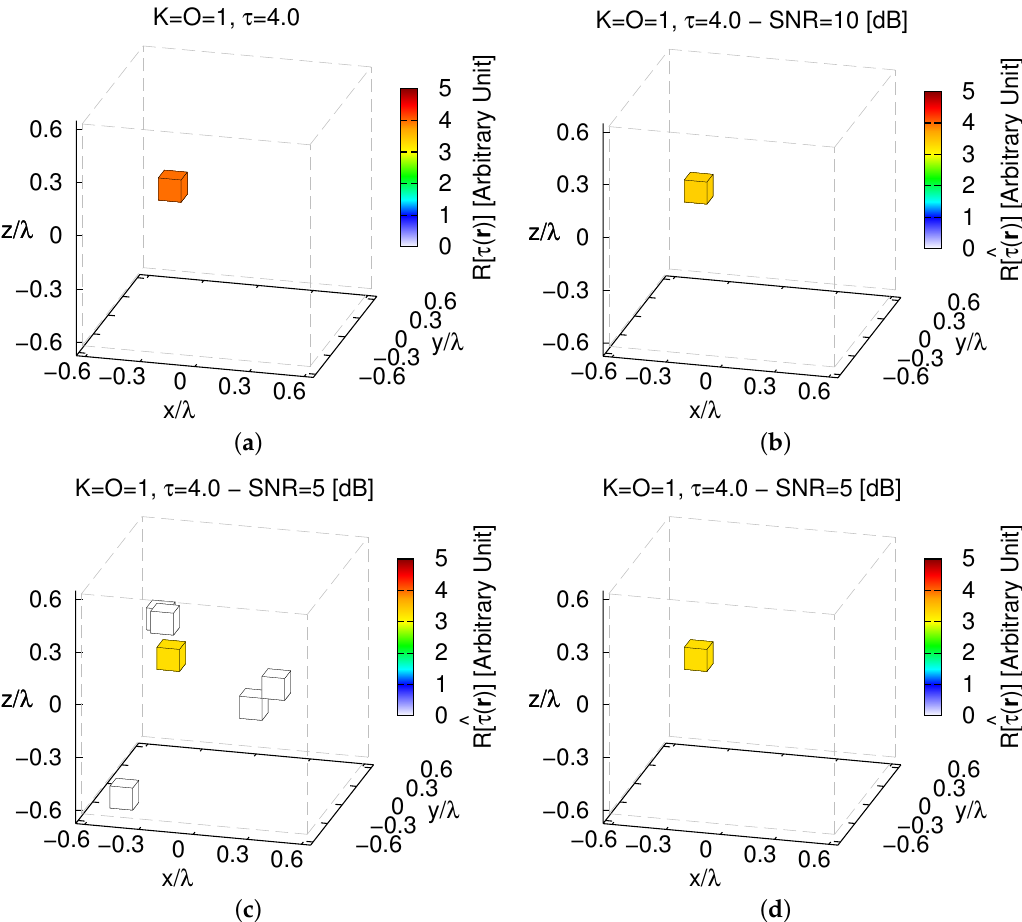
Figure 5. Numerical Assessment ( K = 1, O = 1, τ = 4.0)—( a ) Actual contrast function and ( b , c ) MT-BCS reconstructions when processing the scattering data with ( b ) SNR = 10 [dB] ( (cid:98) τ = 3.40), ( c ) SNR = 5 [dB] (unfiltered) ( (cid:98) τ = 3.28), and ( d ) SNR = 5 [dB] (filtered τ th = 10 − 3 ) ( (cid:98) τ =